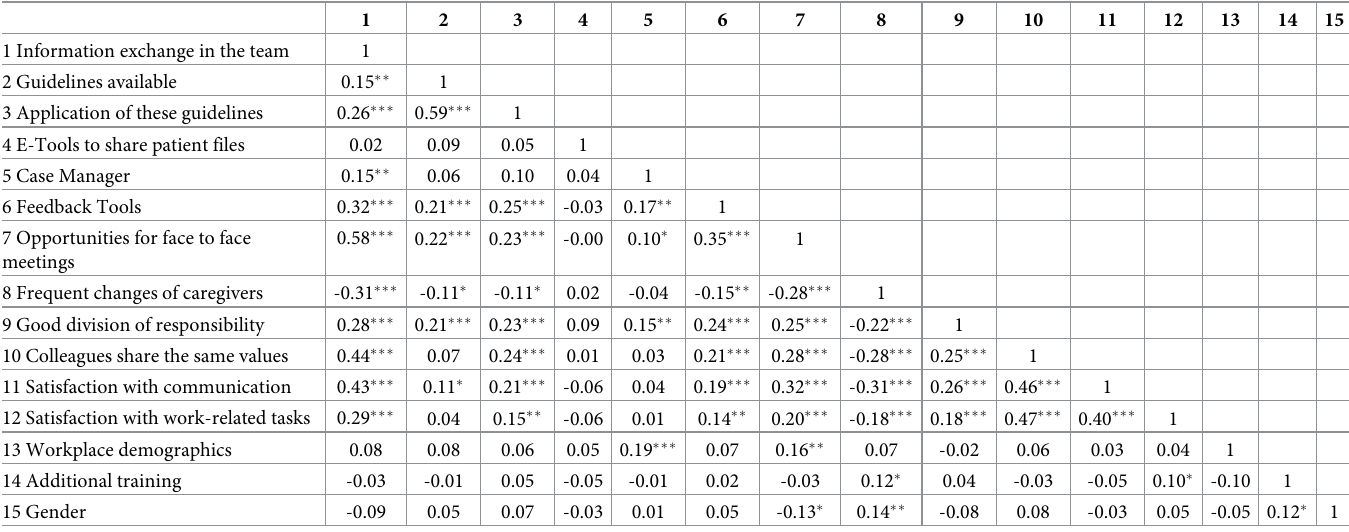
Table 2. Standard deviations and correlations with confidence